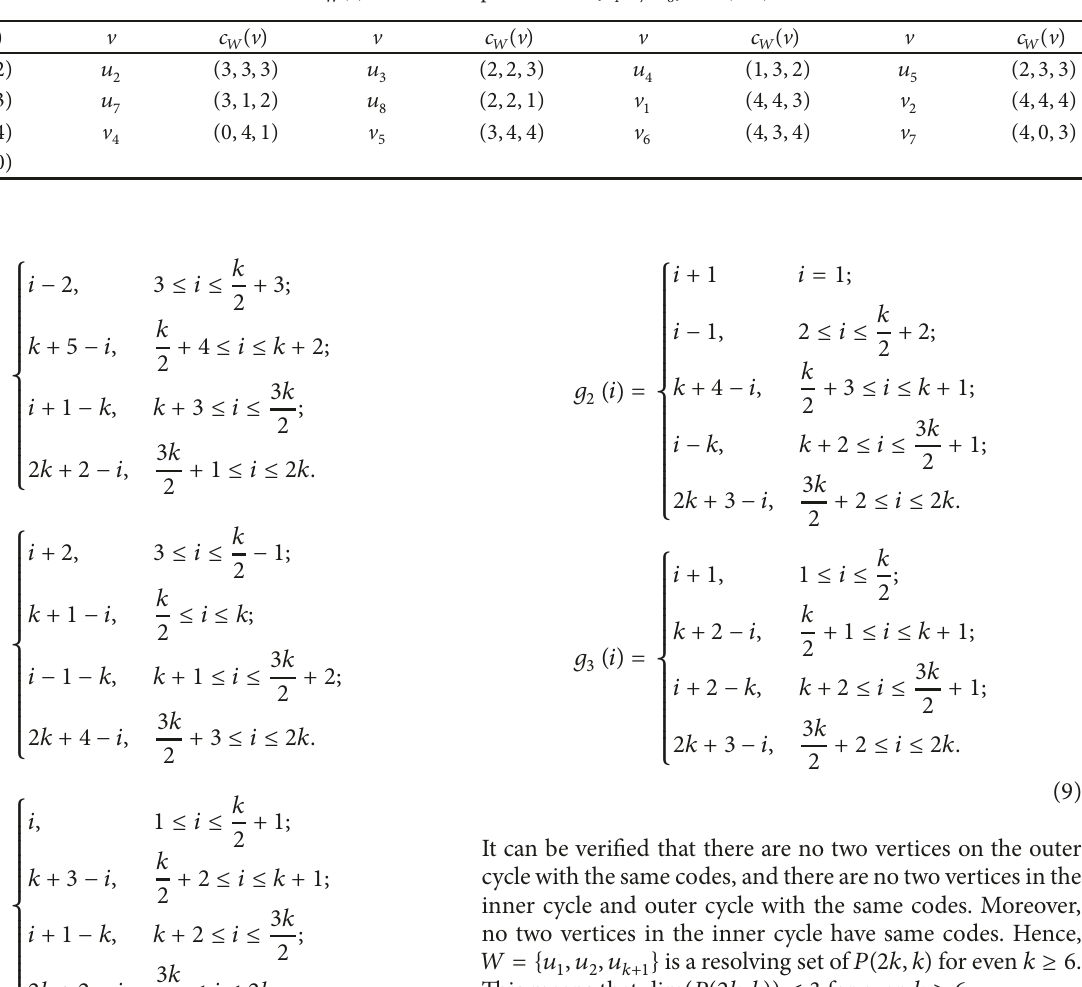
Table 12: The code 𝑐 𝑊 ( V ) of V with respect to 𝑊 = { V 4 , V 7 , V 8 } in 𝑃(8,4)